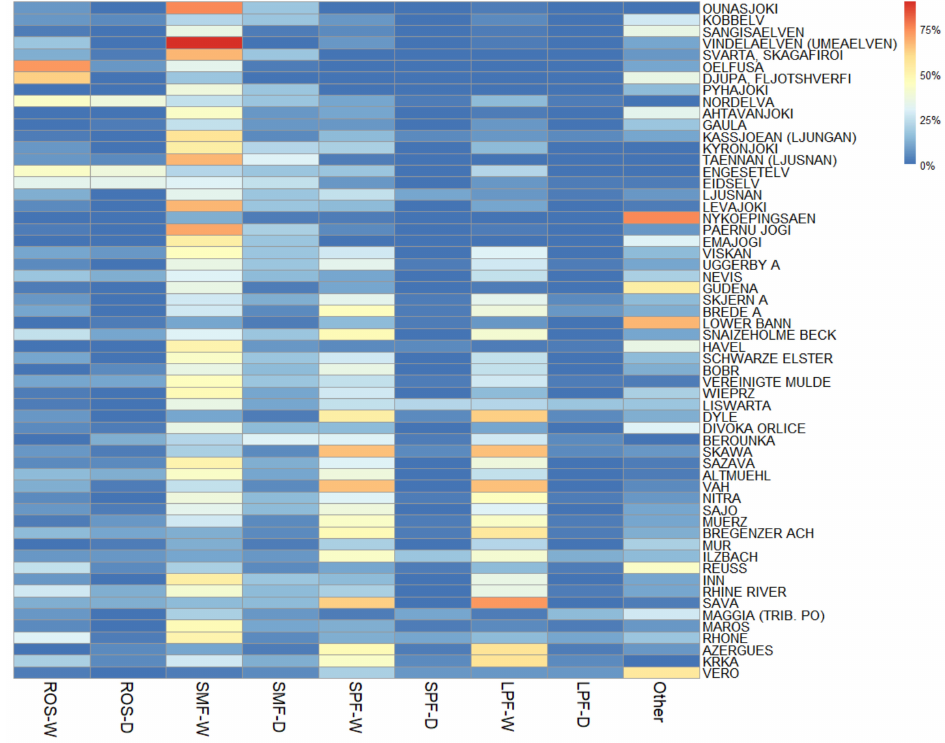
Figure 7. Heatmap for the European catchment distribution of annual maximum (AM) flood typolo- gies. Catchments are sorted from south to